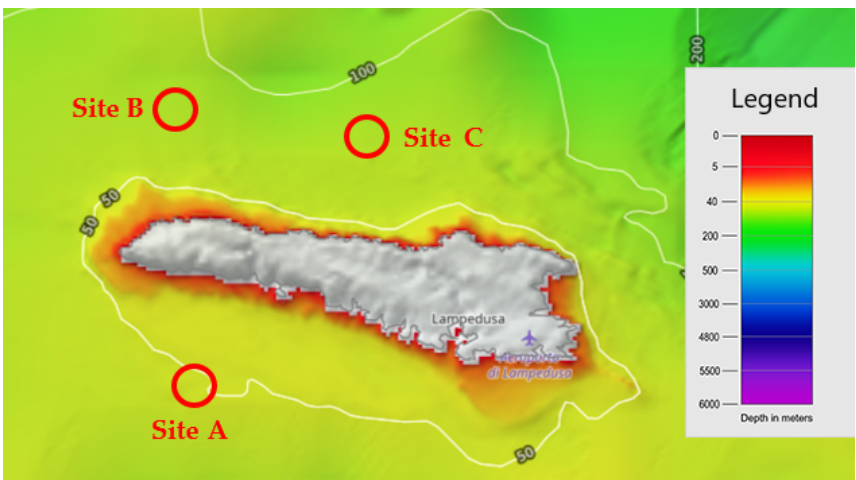
Figure 7. Monthly electricity production in Lampedusa.